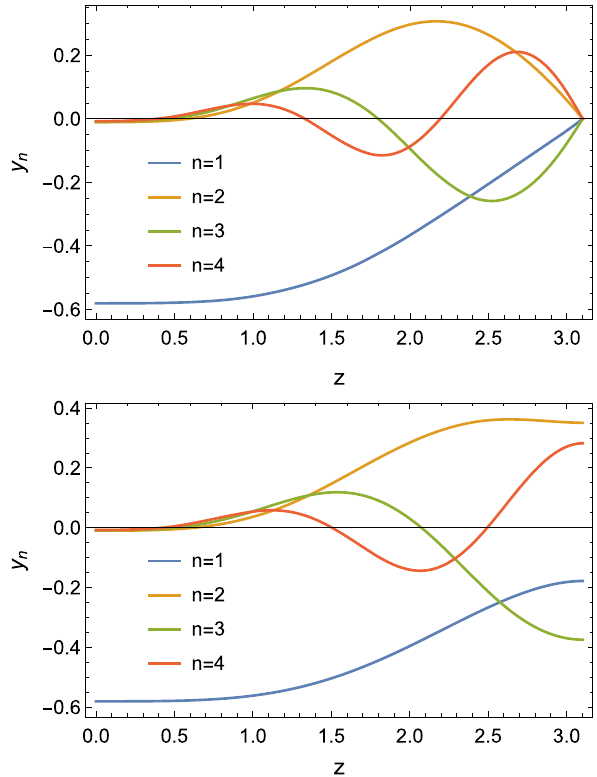
Fig. 5 The first four pion mode functions y n ( z ) in the HW1m model and in the HW3m version, with z in units of inverse GeV; the y n have units of GeV, with y n ( 0 ) = − g 5 f π The difference between these two n models is the different IR boundary conditions. (Figure taken from